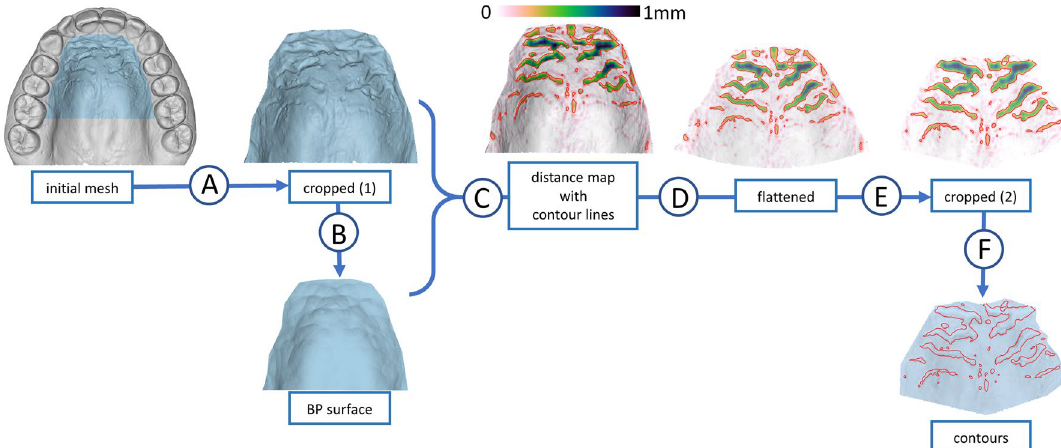
Figure 1. Steps of the method. (A) Initial cropping; (B) ball pivoting; (C) distance mapping and creation of isolines (contour lines); (D) flattening; (E) final cropping; (F) removal of the texture. BP surface, ball pivoting